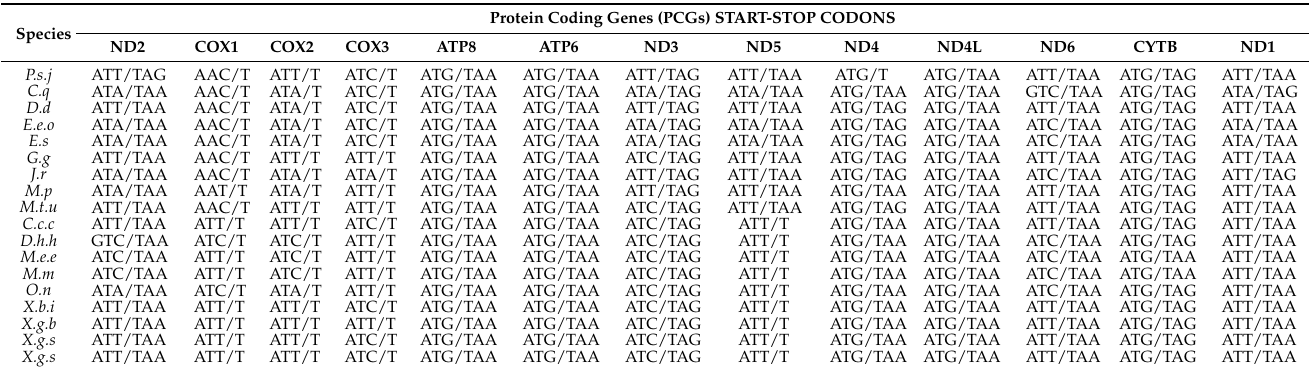
Table 2. Comparative start and stop codons of Cetoniinae and Dynastinae mitochondrial genomes. Cetoniinae species designations are shaded: Protaetia speciosa jousselini (P.s.j), Cyprolais quadrimaculata (C. q), Dicronorhina derbyana (D. d), Eudicella euthalia oweni (E e. o), E. smithi (E. s), Goliathus goliatus (G. g), Jumnos ruckeri (J.r.), Mecynorhina polyphemus, M. t. ugandensis (M.t. u) . Dynastinae species designations are shaded: Chalcosoma caucasus caucasus (C.c.c), Dynastes